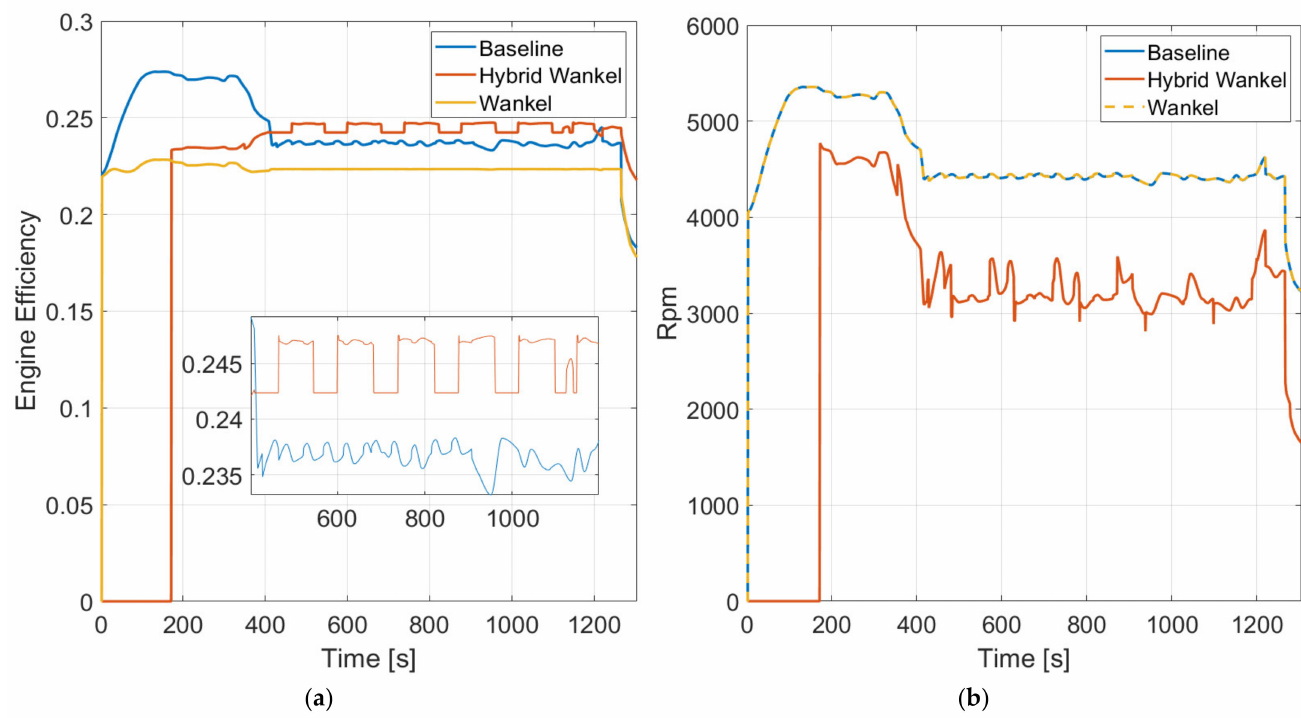
Figure 14. Wankel hybrid electric vs. conventional piston engine efficiency ( a ) and speed ( b